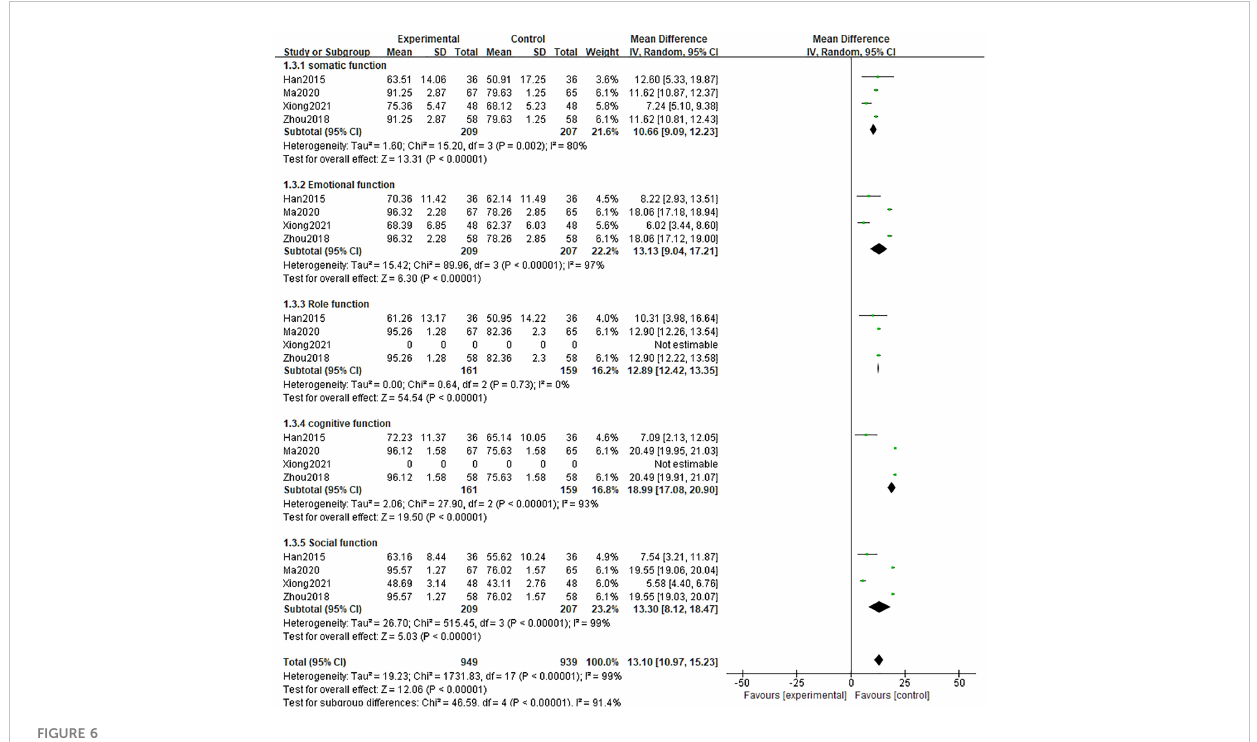
FIGURE 6 Forest analysis map of comparison of life quality